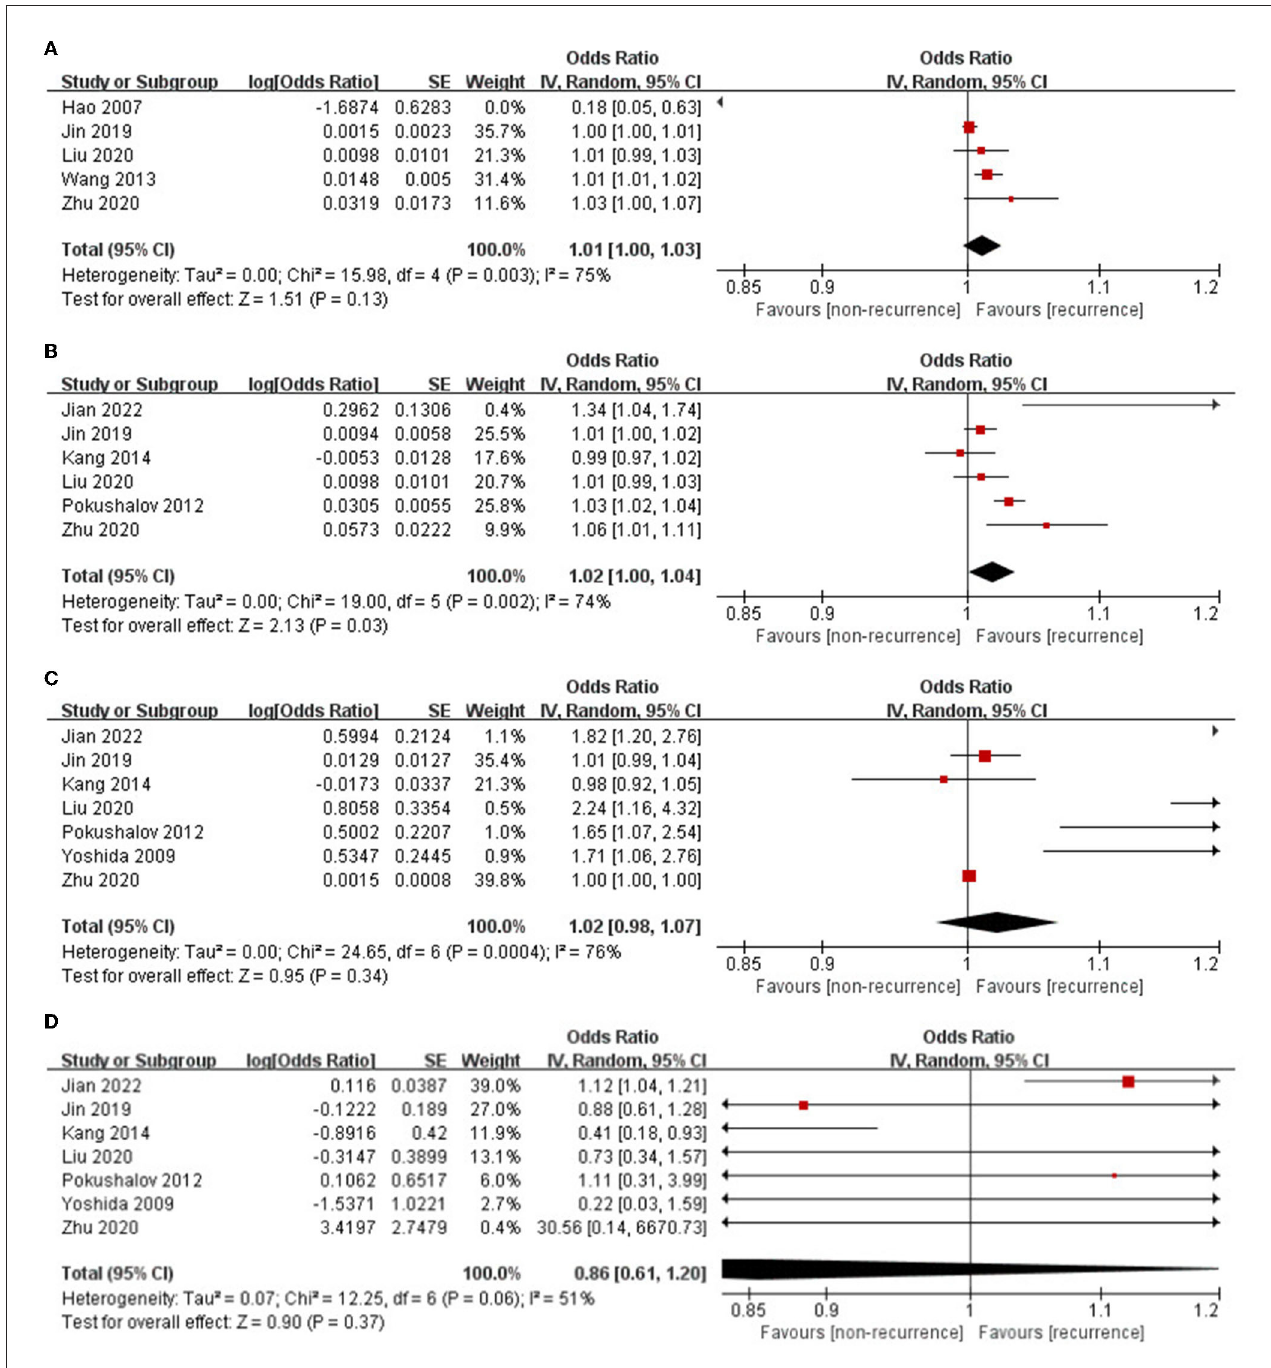
FIGURE2 (A–D) Association between HRV and AF recurrence after catheter ablation.